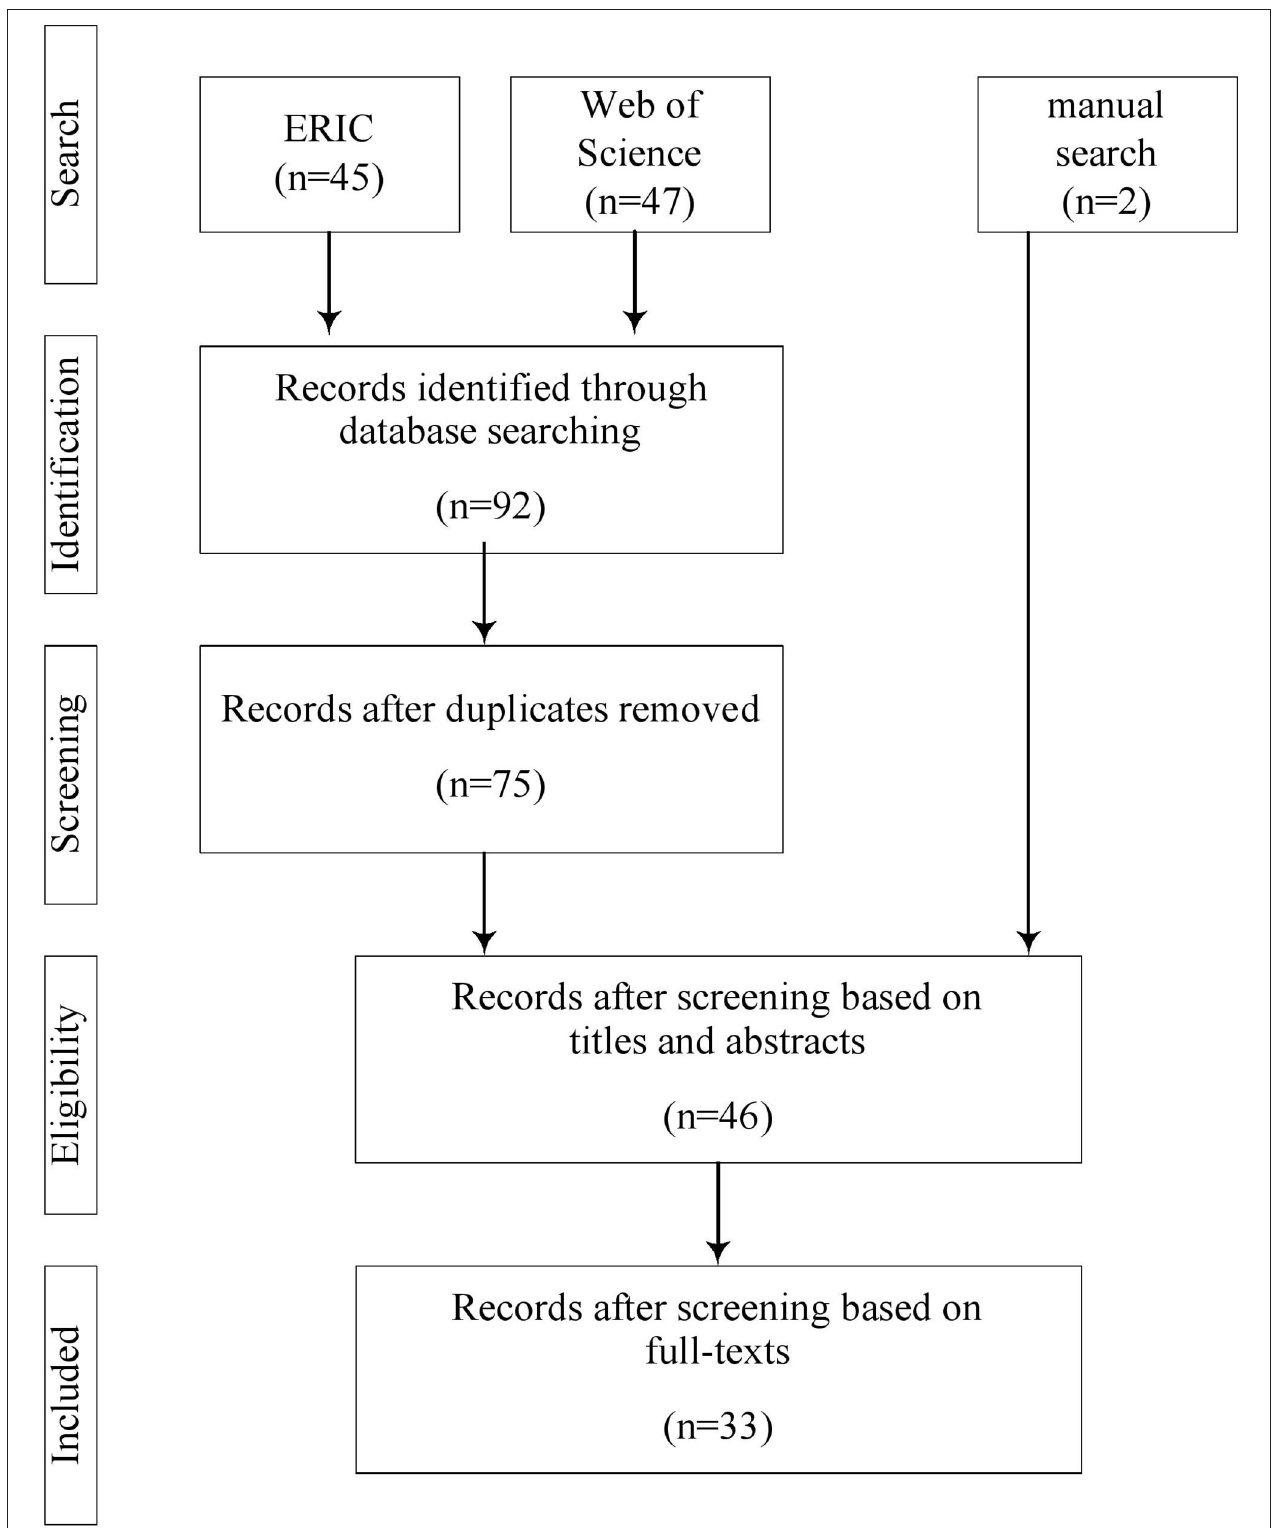
FIGURE 1 | Flowchart diagram of the screening and selection procedure (Moher et al., 2009, p. 267).